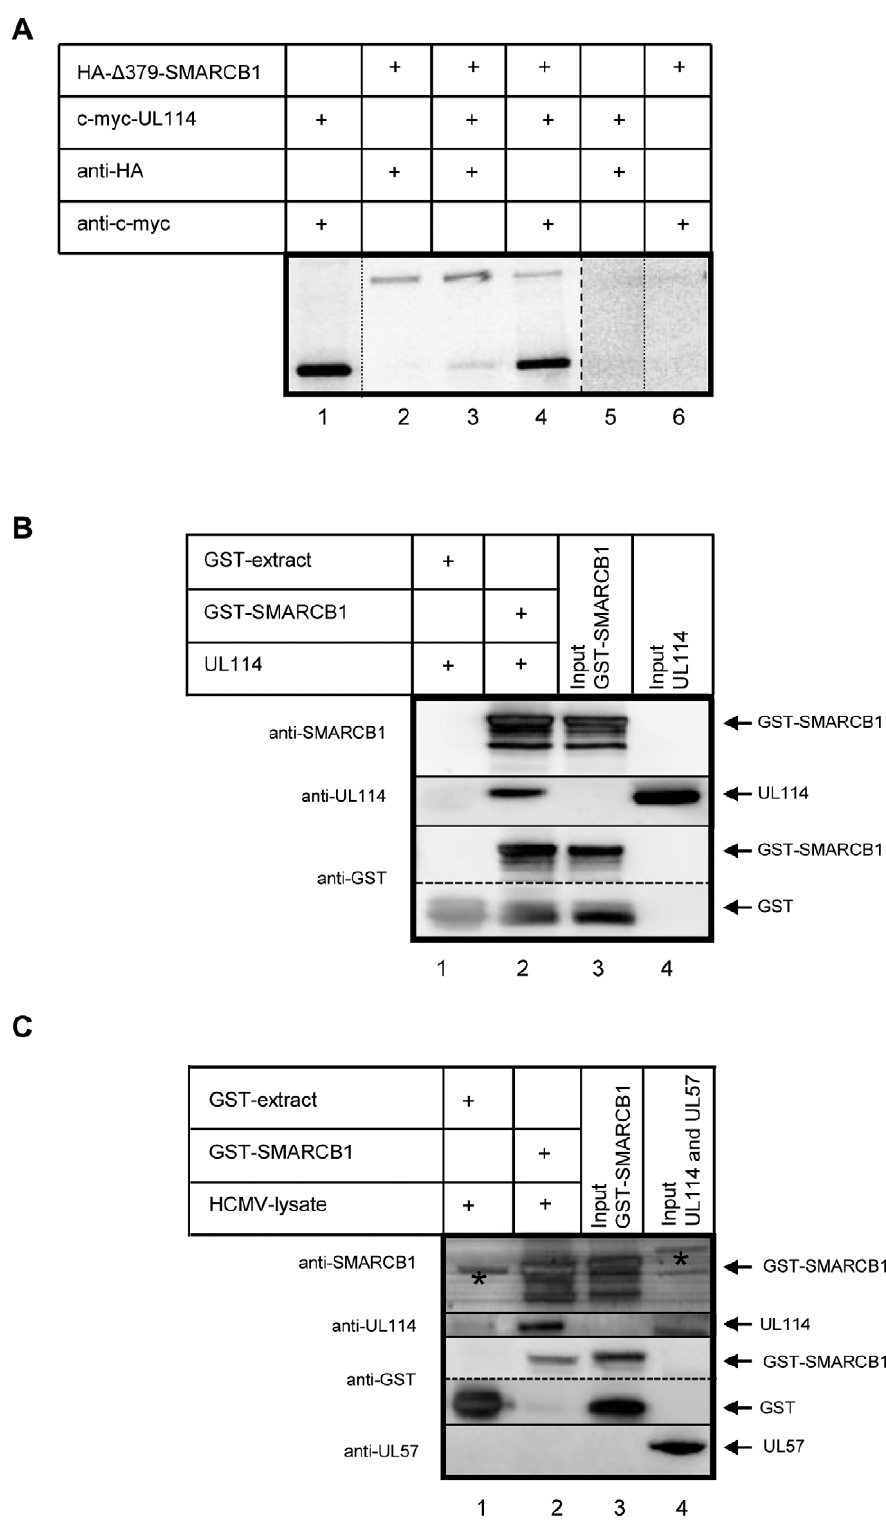
Figure 2. SMARCB1 and UL114 interact invitro . ( A ) In vitro binding analysis of HA-tagged D 379-SMARCB1 and c-myc-tagged UL114 in 35 S- labeled proteins using the TNT coupled transcription/translation system. The proteins were transcribed and translated in vitro with 35 S-methionine in the translation mixture to generate radioactive labeled products from vectors pACT2- D 379-SMARCB1 (HA-epitope) and pGBKT7-UL114 (c-myc epitope). The translated D 379-SMARCB1-HA and UL114-c-myc were immunoprecipitated with either anti-HA or anti-c-myc-antibodies and eluted from the Protein G beads. Samples were subjected to 8% SDS-PAGE and PhosphoImaging. Lane 1: UL114-c-myc + c-myc antibody. Lane 2: D 379- SMARCB1-HA + HA-antibody. Lane 3: D 379-SMARCB1-HA + UL114-c-myc + HA-antibody. Lane 4: D 379-SMARCB1-HA + UL114-c-myc + c-myc antibody.